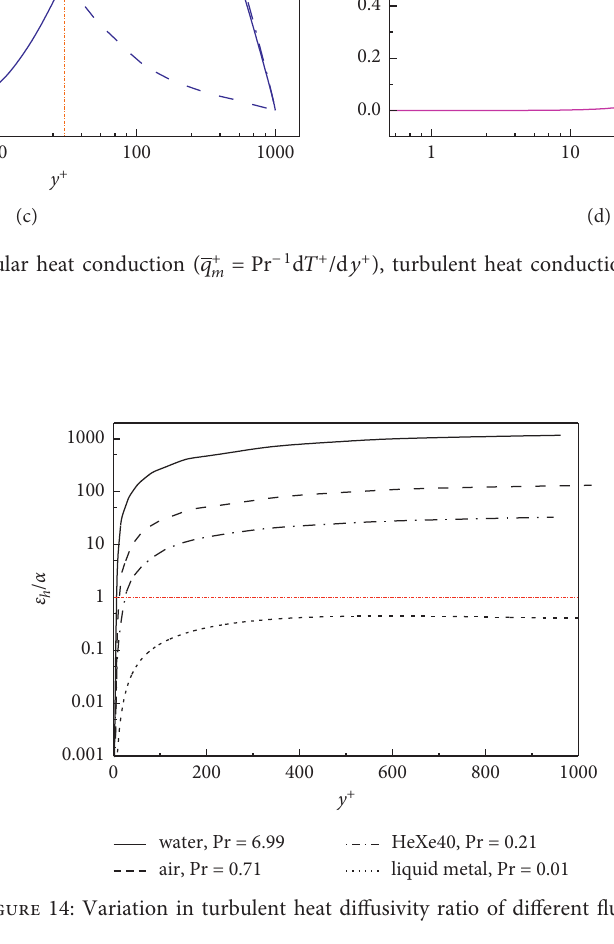
� Pr − 1 d T + /d y + ), turbulent heat conduction ( q + m